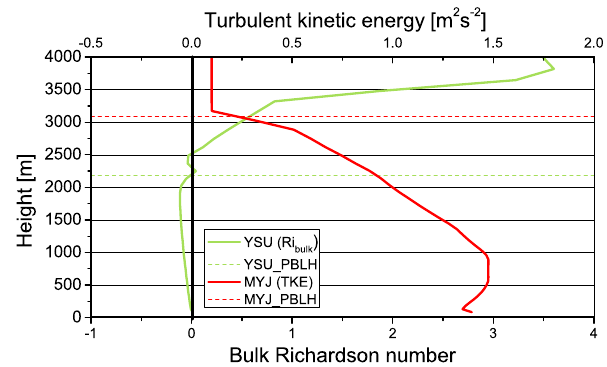
Figure 5. Simulated turbulent kinetic energy (MYJ) and calculated bulk Richardson number (YSU) profile and simulated PBL heights (dashed lines) on 17 July 2012 at 12 UTC.